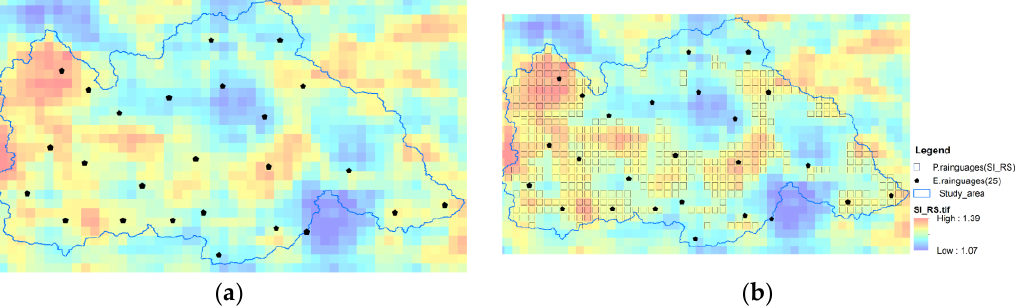
Figure 8. Screening based on SI z ( X ) . ( a ) Spatial distribution of SI z ( X ) and ( b ) 0.5 quantile potential station distribution based on quantile screening.